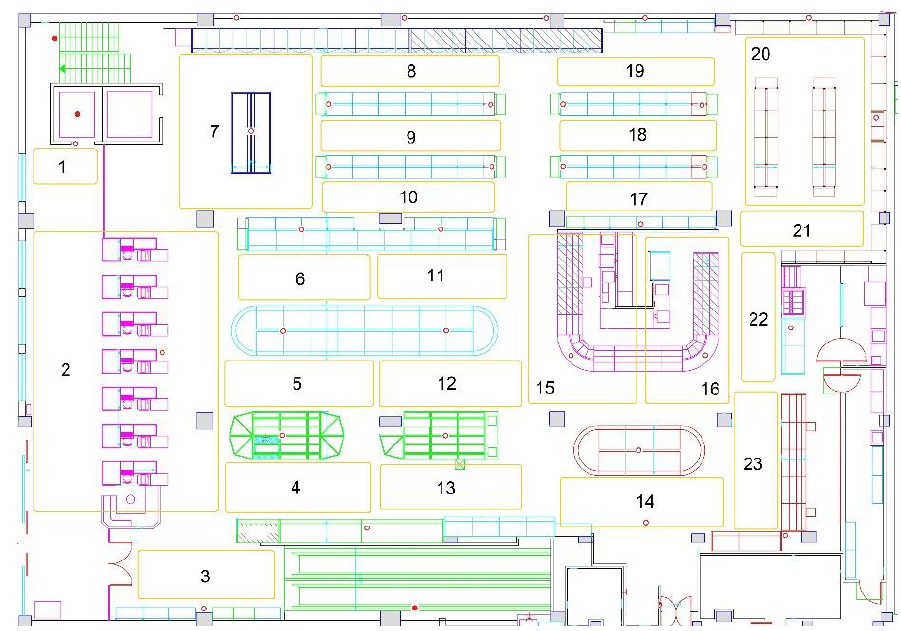
Figure 3. Map of the BLE beacon-enabled ground floor of the grocery store (store areas are labelled with a number from 1 to 23, beacons are presented in red circles, elevator beacons are filled with red color).